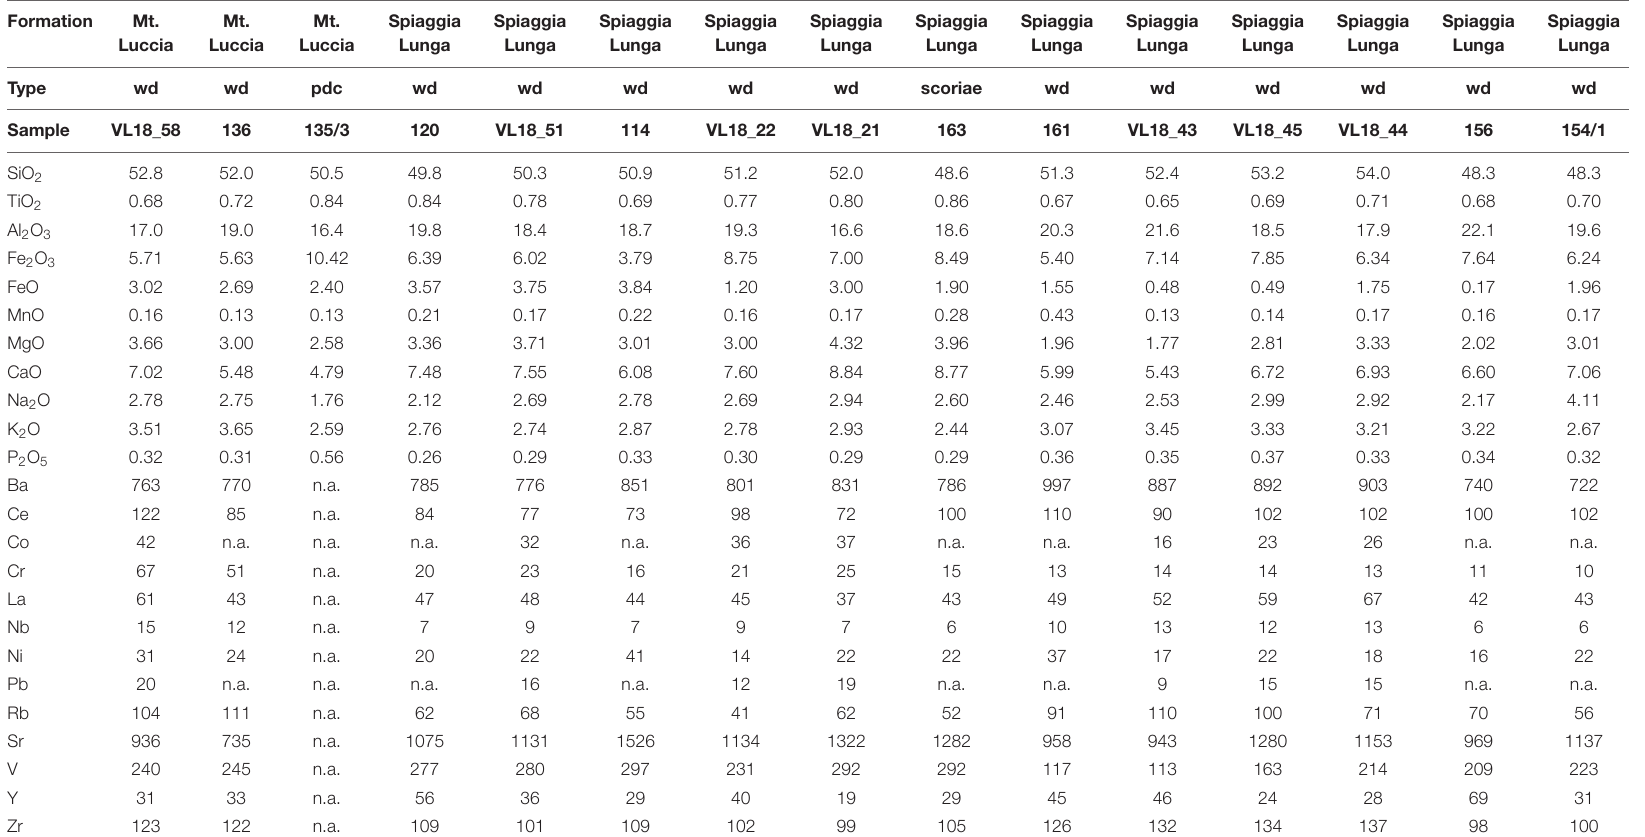
TABLE 1 | Whole rock composition for the considered eruptive events.